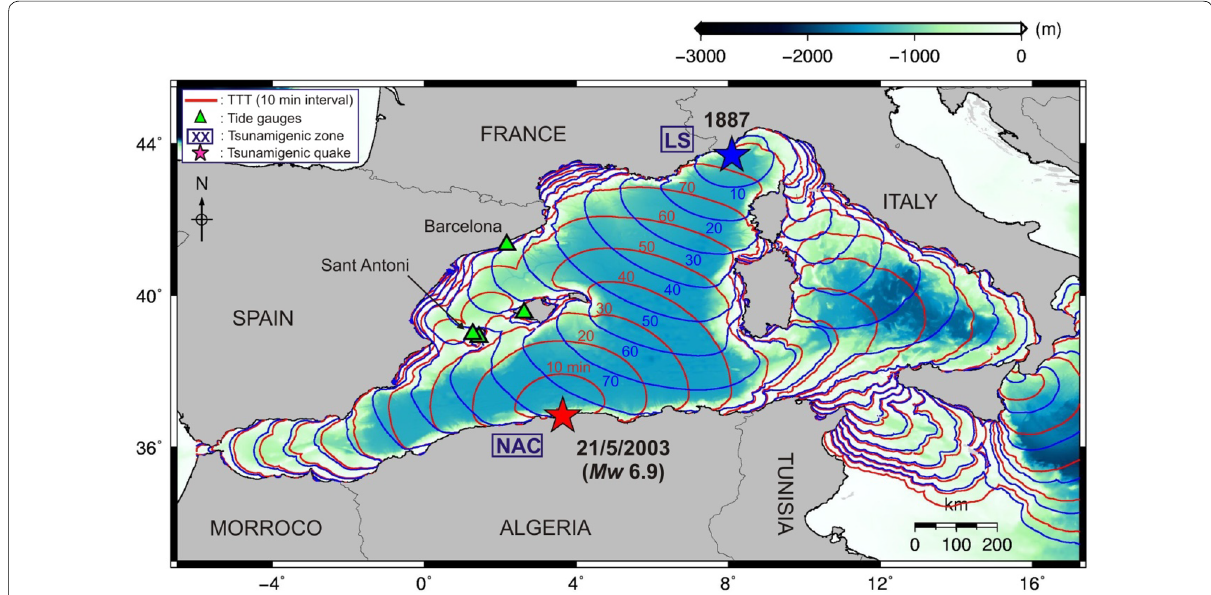
Fig. 2 Tsunami travel time (TTT) analysis for the 21 May 2003 (offshore Algeria) tsunami and the 1887 Ligurian Coast tsunami with contours of 10-min